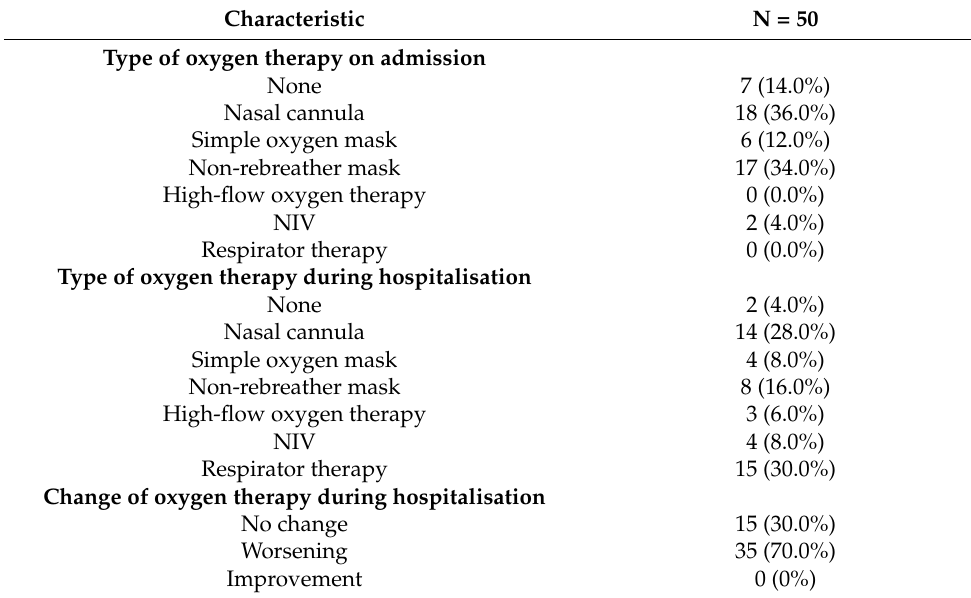
Table 5. Data on patient condition during hospitalisation.